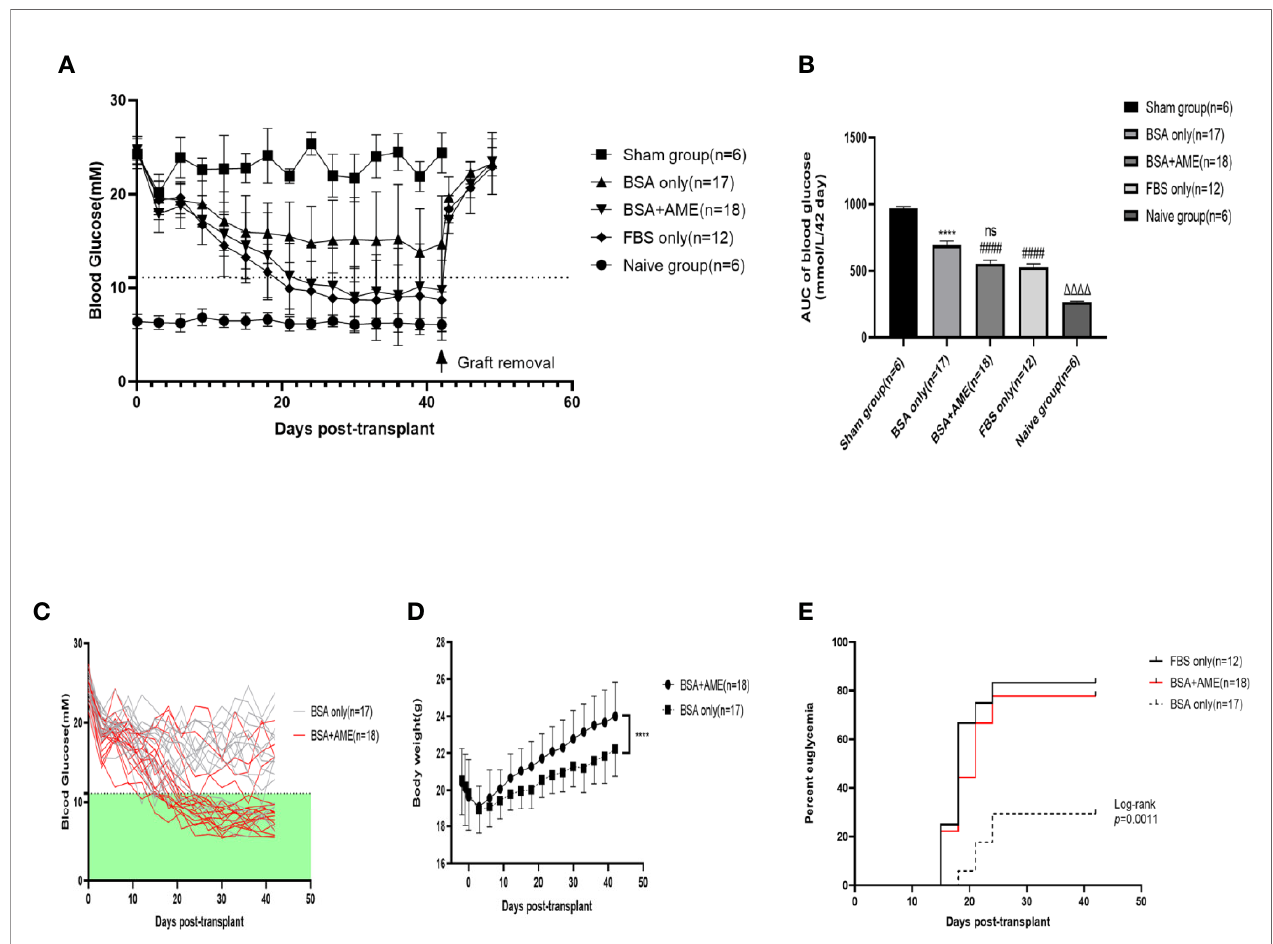
FIGURE 6 | Regulation of recipient blood glucose. Islets were cultured in different conditions (BSA only, BSA + AME [0.5 mg/ml], and FBS only) prior to transplantation. Non- fasting blood glucose was measured every 3 days post-transplantation (A) . Non-fasting blood glucose curves of islet recipients and the control group. Data are shown as means ± SD. The dotted line indicates the level of 11.1 mmol/l (B) . AUC of non-fasting blood glucose, expressed as mmol/L/42days ( #### p < 0.0001 and ns when BSA + AME group [N = 18] was compared to BSA only [N = 17] and FBS only group [N = 12]; ****p < 0.0001 when BSA only group was compared to the Sham group [N = 6]; DDDD p < 0.0001 when Naïve group [N = 6] was compared to BSA + AME and FBS only group, One-way ANOVA) (C) . Non-fasting blood glucose of individual recipients in BSA only and BSA + AME group (D) . Body weight monitoring of graft recipients in BSA + AME and BSA only group (****p < 0.0001 when BSA + AME group [N = 18] was compared to the BSA only [N = 17] group, Unpaired t-test) (E) . The percentage of recipients achieving euglycemia. p = 0.0016 for the post hoc comparison of BSA only and BSA + AME group. p = 0.5270 for the post hoc comparison of BSA+AME and FBS only group (Log-rank [Mantel-Cox] test).